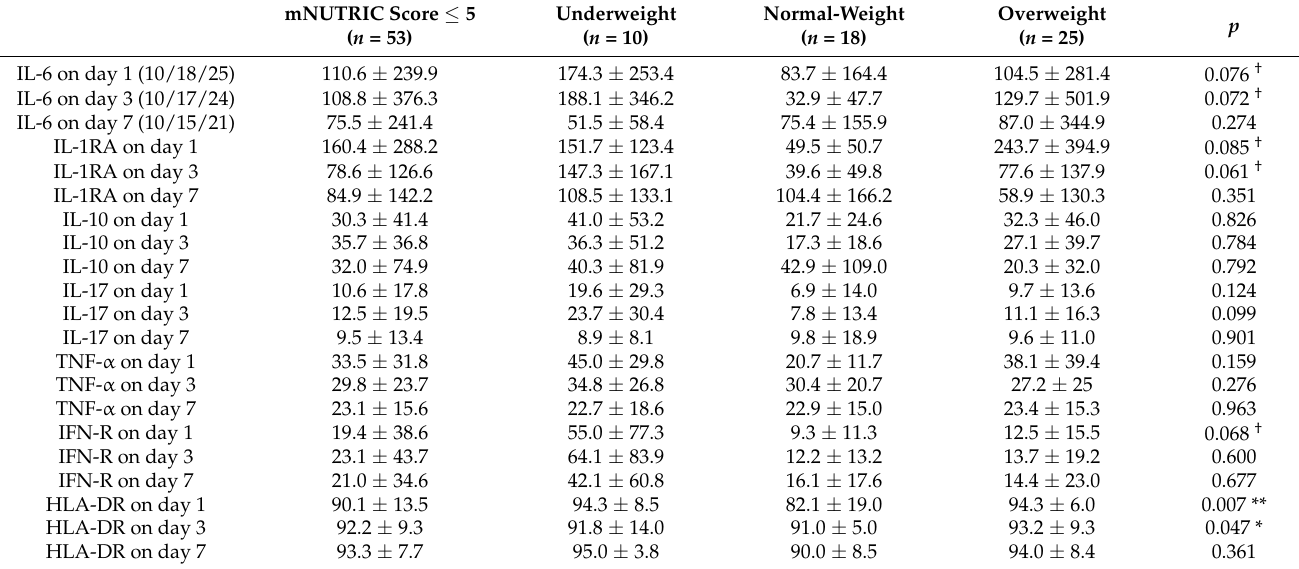
Table 6. Biomarkers of patients with sepsis who had low modified NUTRIC scores.